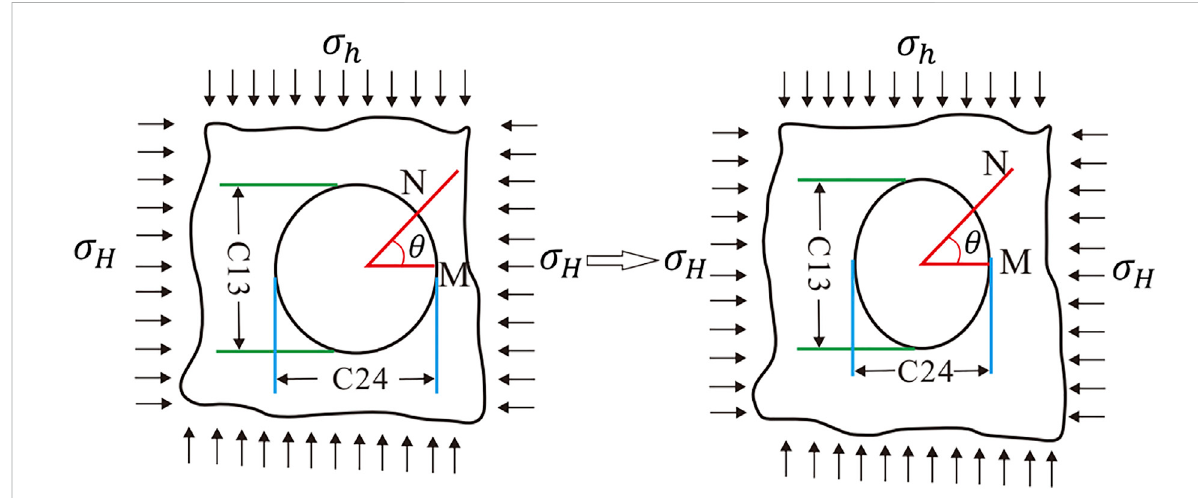
FIGURE 5 Diagram of the relation between long and short axes and diameters of the elliptic borehole.